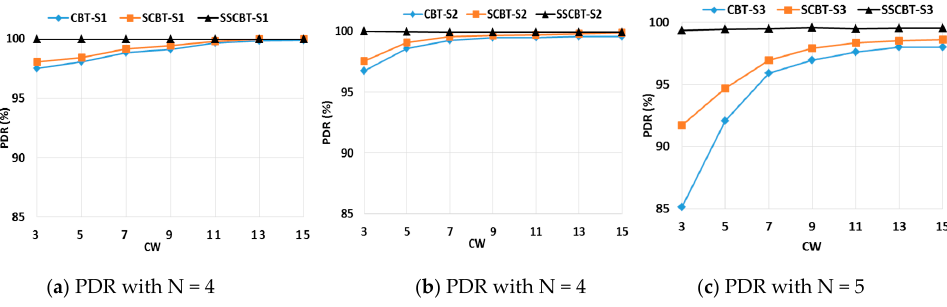
Random Table 5. Two dynamic network scenarios corresponding to S2 and S3 in Table 4. Parameters